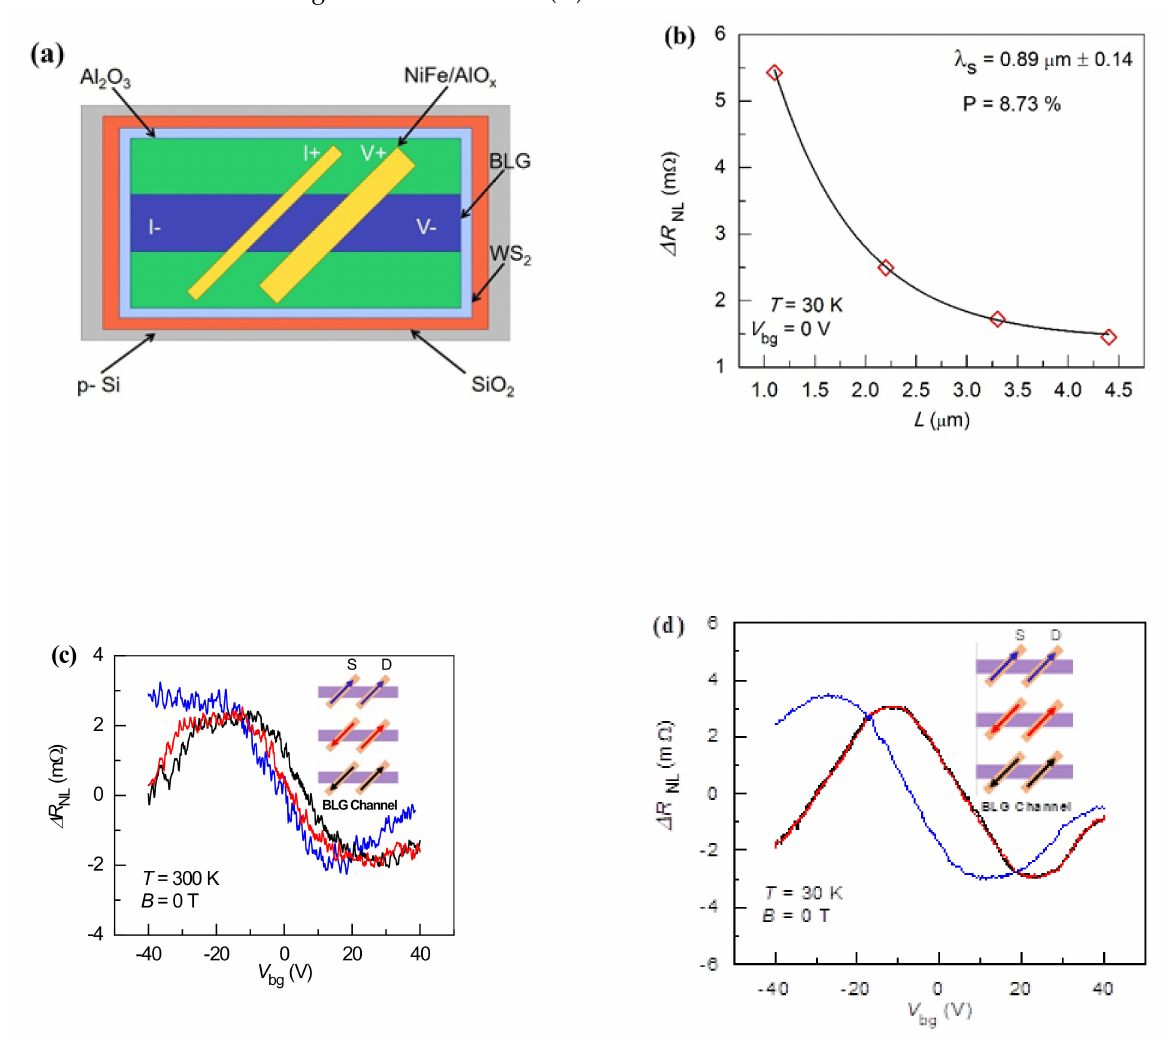
Figure 2. ( a ) NL measurement configuration of spin injection and detection. ( b ) Exponential decay of the NLSV signal with L of injector and detector. ( c ) NLSV spin signal as a function of V bg at B = 0 T and T = 300 K for parallel (blue line), anti-parallel (red line), and anti-parallel (black line), respectively. ( d ) NLSV spin signal as a function of V bg at B = 0 T and at 30 K for parallel (blue line), anti-parallel (red line), and anti-parallel (black line), respectively. The NLSV signals are moving-averaged to remove noise from a data